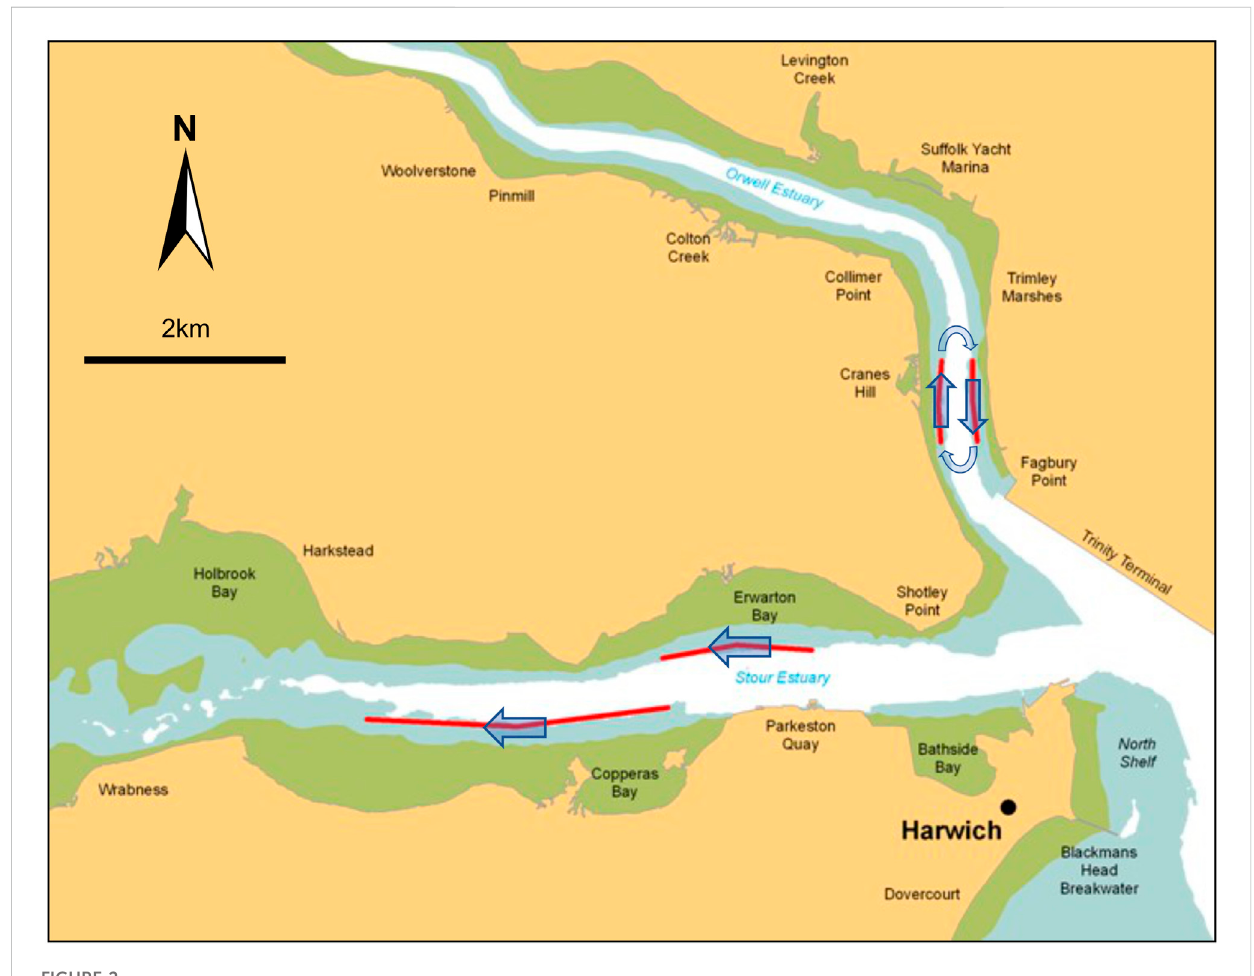
FIGURE 2 Sediment recycling